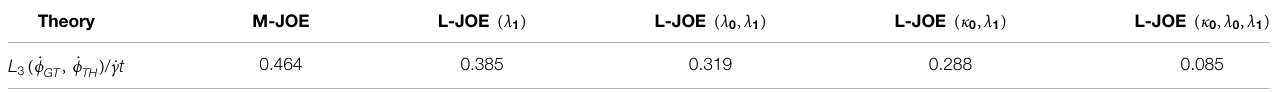
TABLE 2 | Improvement from M-JOE to L-JOE.